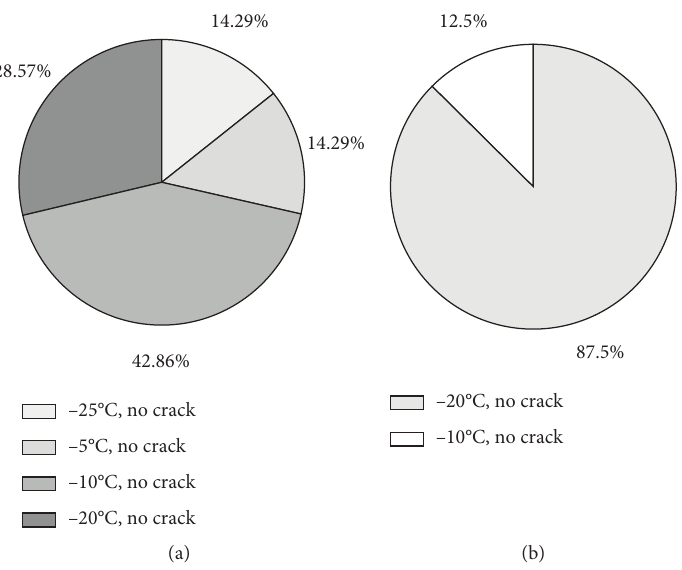
Figure 9: Low temperature properties: (a) epoxy resin; (b)